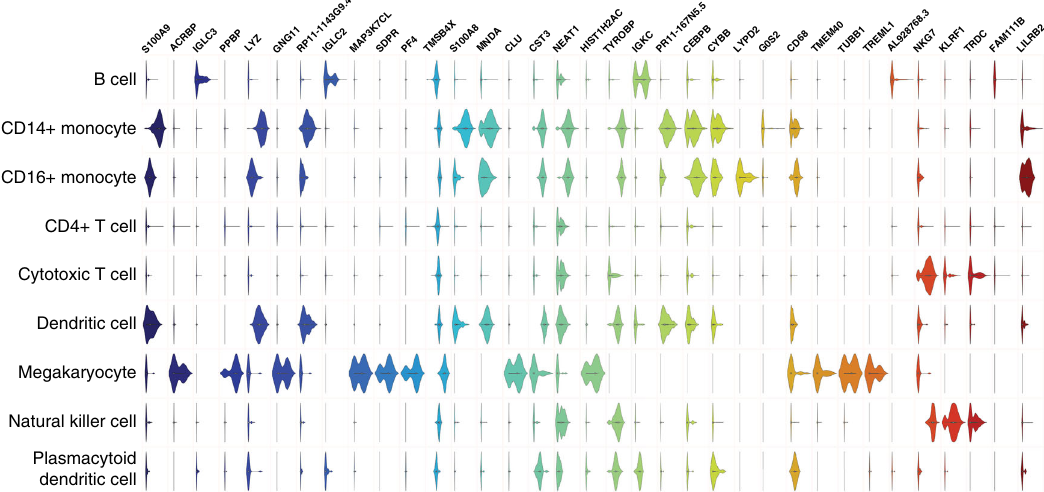
Fig. 5 Normalized expression levels of 35 top-ranked feature genes detected by EDGE for the PBMC dataset. Genes are ordered by their importance scores with S100A9 (the most left on top) having the highest importance